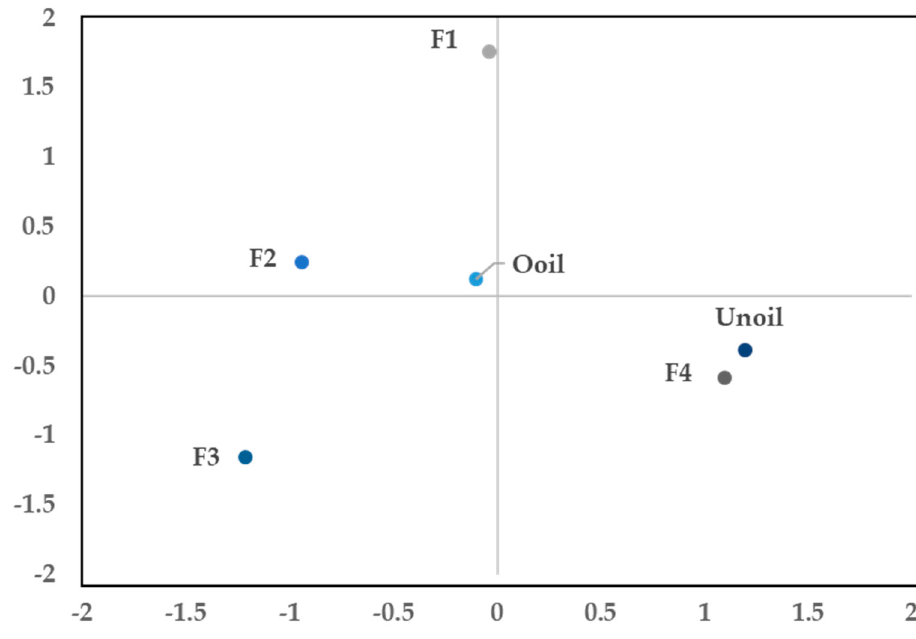
Figure 3. Diagram of the fractions in a single factorial plane.